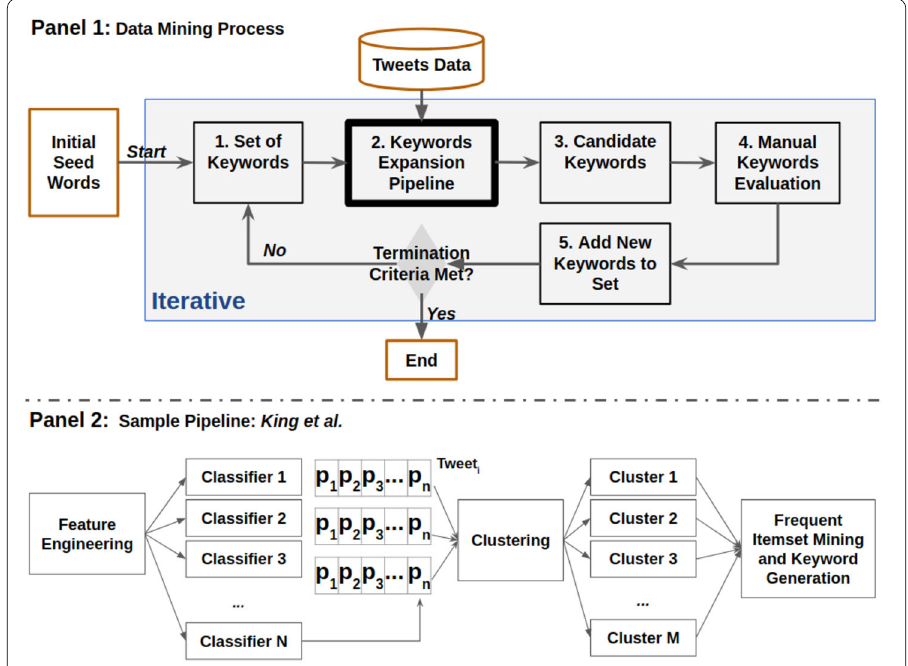
Figure 1 Overview of the Data Mining Process (Panel 1) and Sample Keyword Expansion Pipeline (Panel 2). Note, Sect. 3.1 describes the data collection process for tweetsdata and initialseedwords . Section 3.2